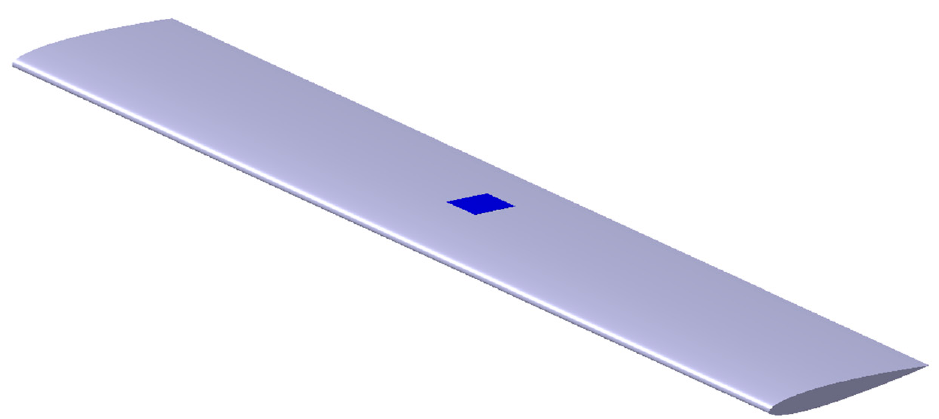
Figure 26. Design of base platform for experimental validations.